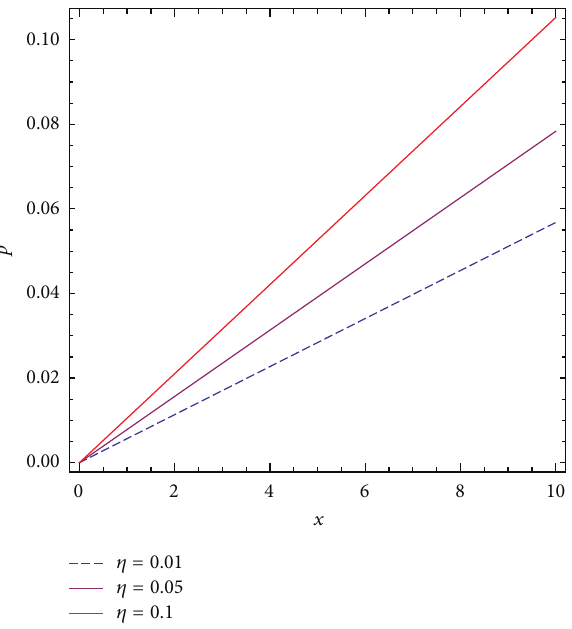
Figure 4: The optimal value function varies with respect to 𝑢 at high level.